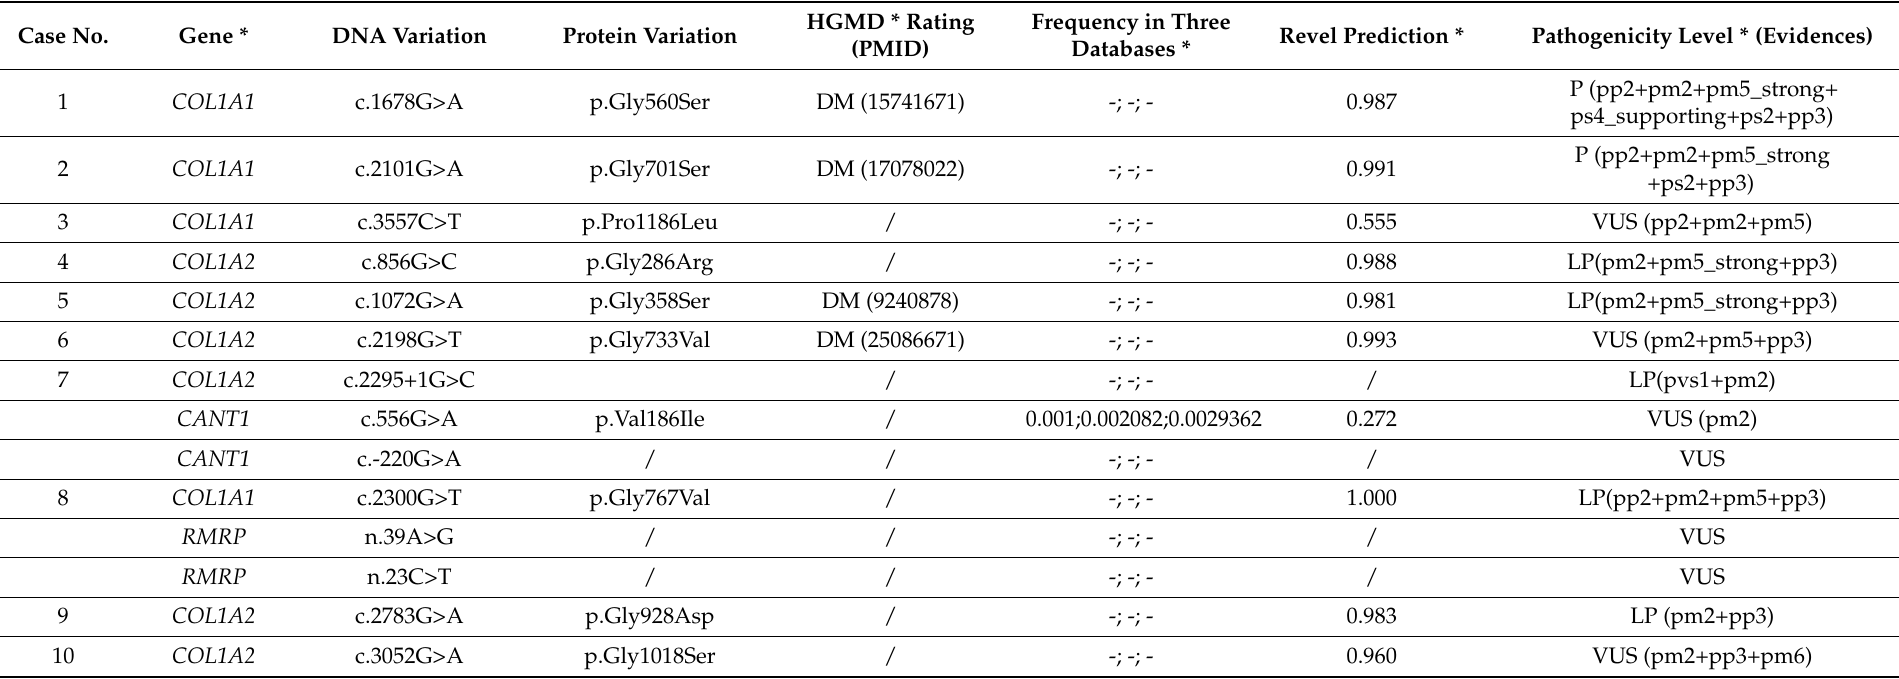
Table 2. Information of the genetic variations identified in this